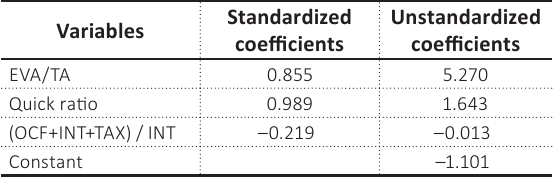
Table 14. Coefficients of the discriminant